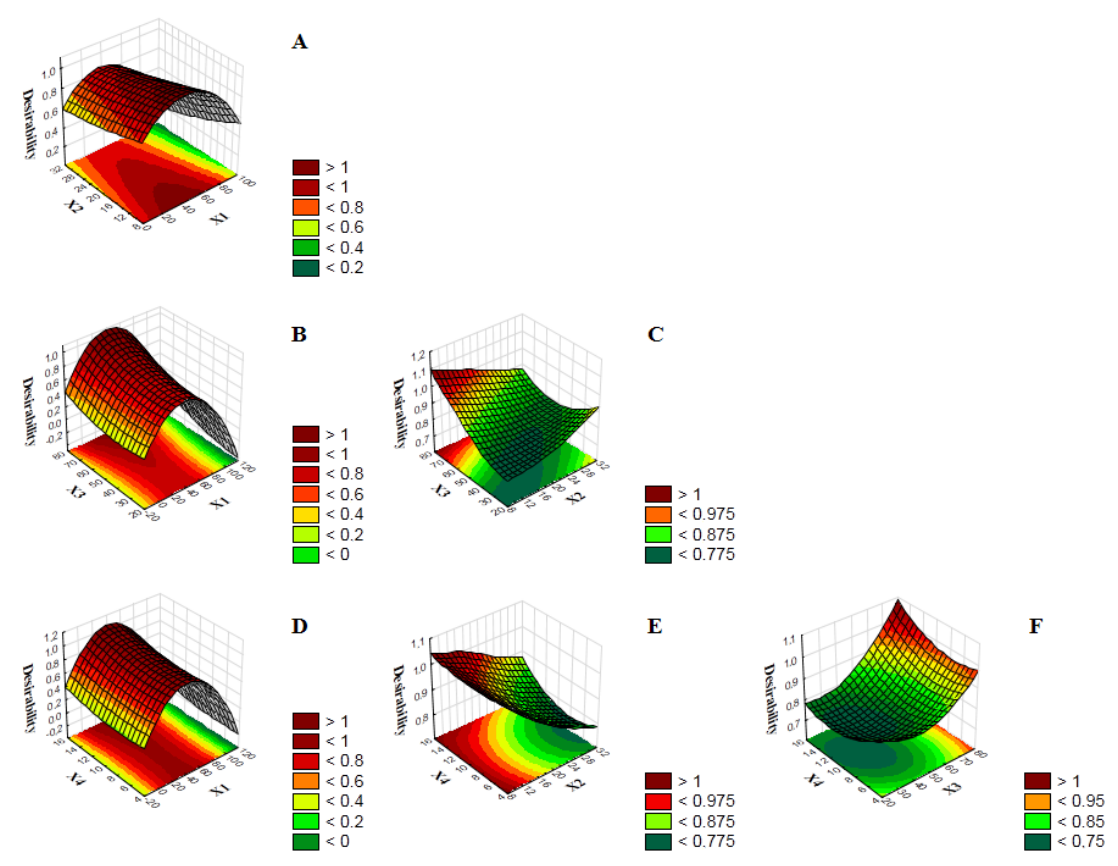
Figure 3. Response surface and contour plots of kiwifruit pomace extracts as a function of ( A ) X 1 = solvent composition and X 2 = solid-to-solvent ratio; ( B ) X 1 = solvent composition and X 3 = temperature; ( C ) X 2 = solid-to-solvent ratio and X 3 = temperature; ( D ) X 1 = solvent composition and X 4 = extraction time; ( E ) X 2 = solid-to-solvent ratio and X 4 = extraction time; ( F ) X 3 = temperature and X 4 = extraction time.